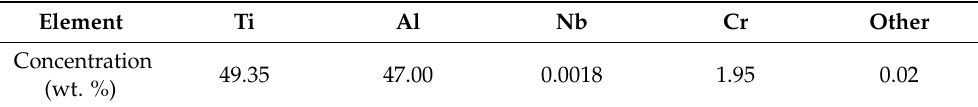
Table 1. Chemical composition of the γ -TiAl used as a substrate. Element Ti Al Nb Cr Other Concentration (wt.